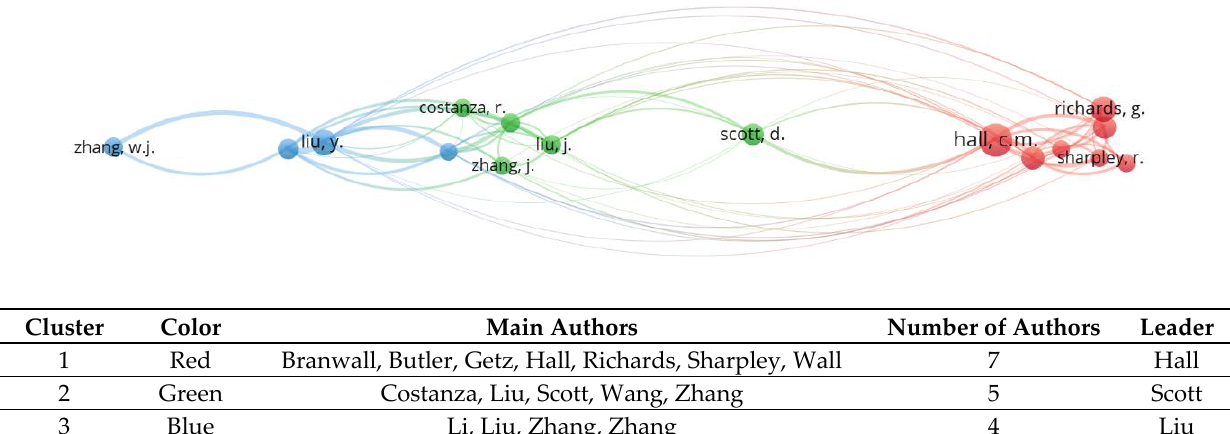
Figure 8. Author co-citation analysis (ACA) in Scopus. Source: Authors’ own data.